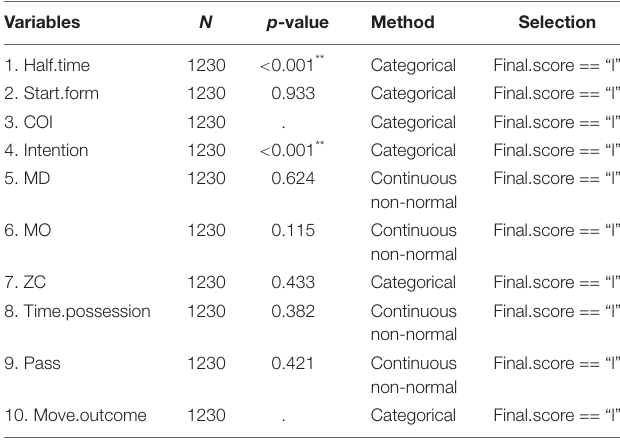
TABLE 2 | Summary of results by groups of “match